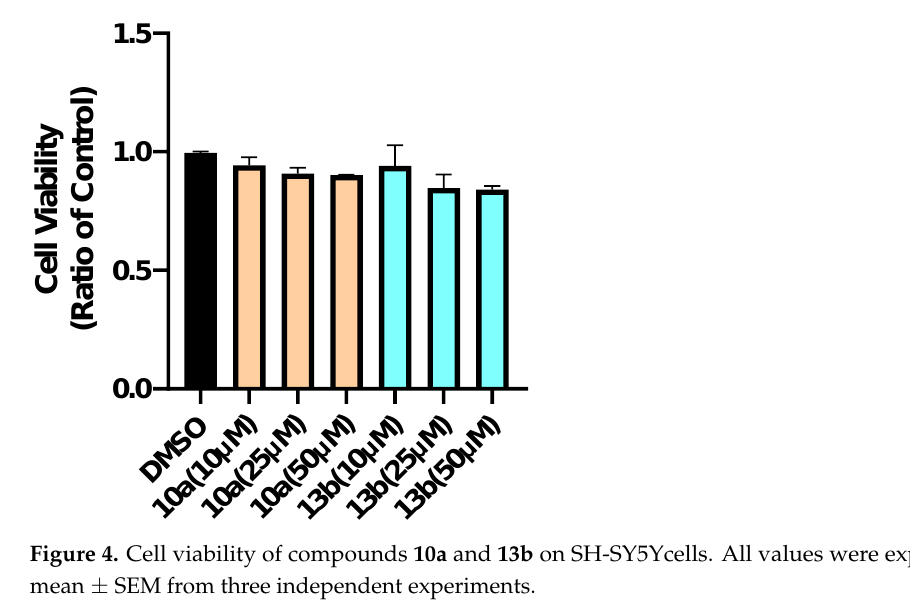
− 2 − 4 Figure 3. Lineweaver – Burk plots generated from the sub-velocity profiles of acetylcholinesterase activity for different substrate concentrations in the absence or presence of 10a (0, 0.8 and 1.6 nM) (All values are expressed as mean ± SEM from three independent experiments). 2.4. In Vitro Cytotoxicity of Compounds 10a and 13b